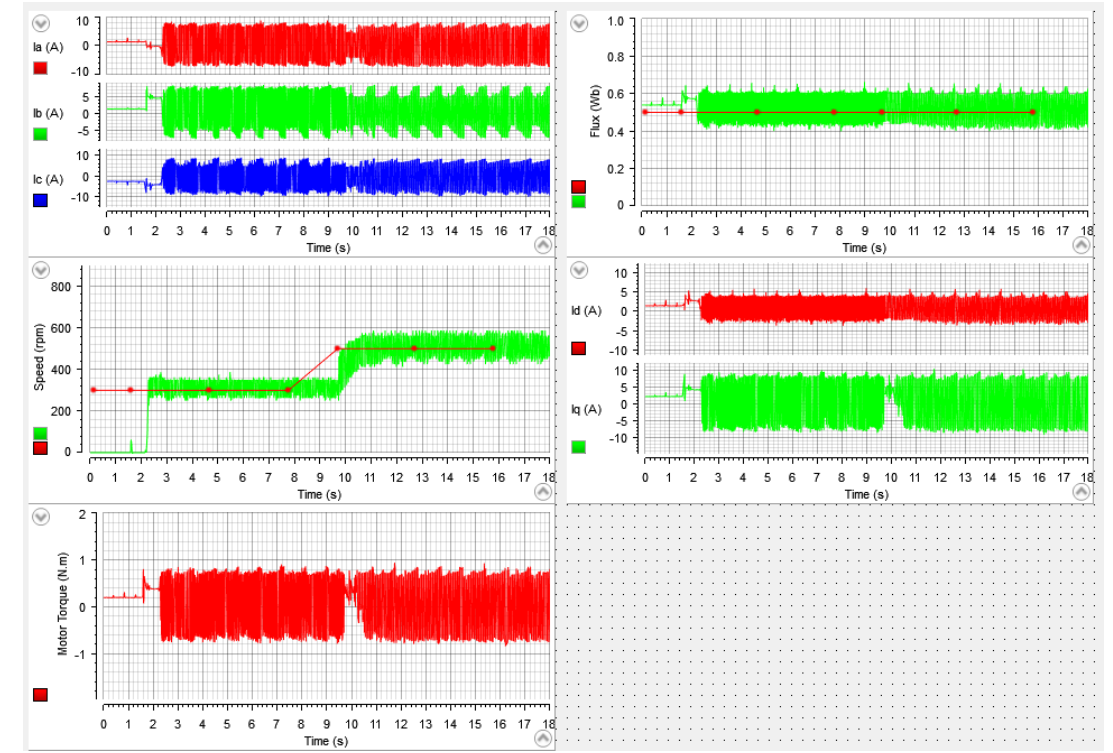
Figure 8. The PMSM performance at speed change.